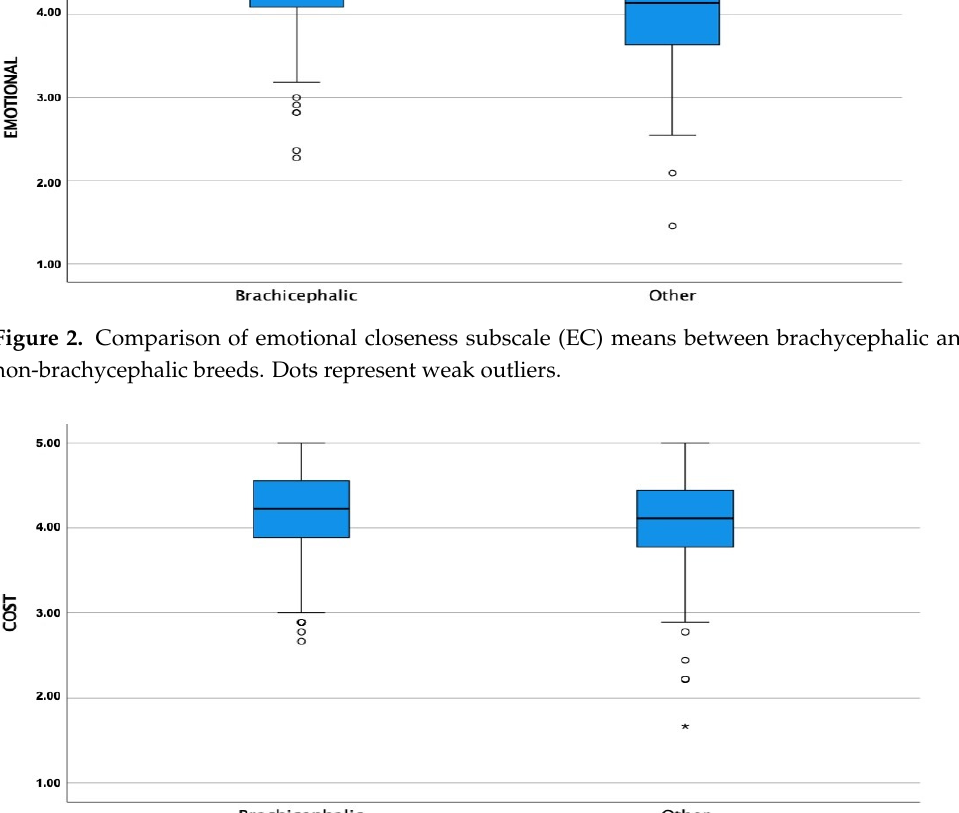
Figure 3. Comparison of perceived cost subscale (PC) means between brachycephalic and non- brachycephalic breeds. Dots represent weak outliers; stars represent strong outliers.